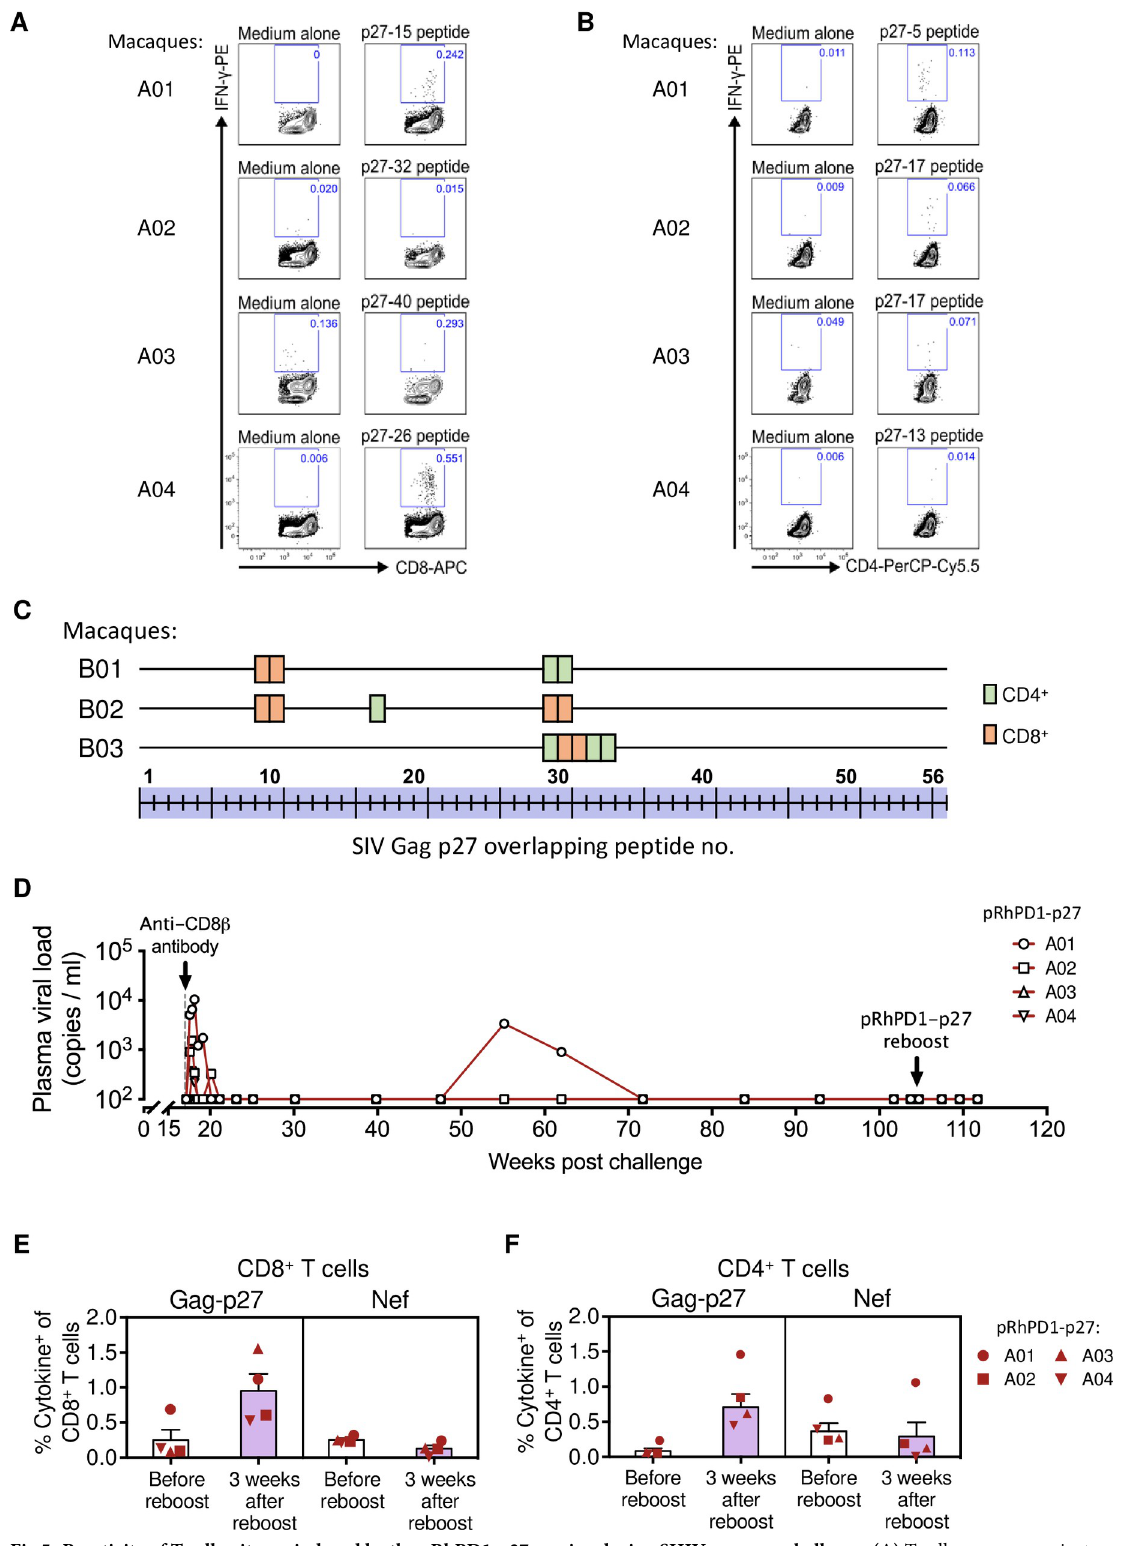
Fig 5. Reactivity of T cell epitopes induced by the pRhPD1-p27 vaccine during SHIV SF162P3CN challenge. (A) T cell responses against the PD1-based vaccine-induced CD8 + and (B) CD4 + T cell epitopes at 17 weeks after SHIV SF162P3CN challenge. (C) T cell epitope